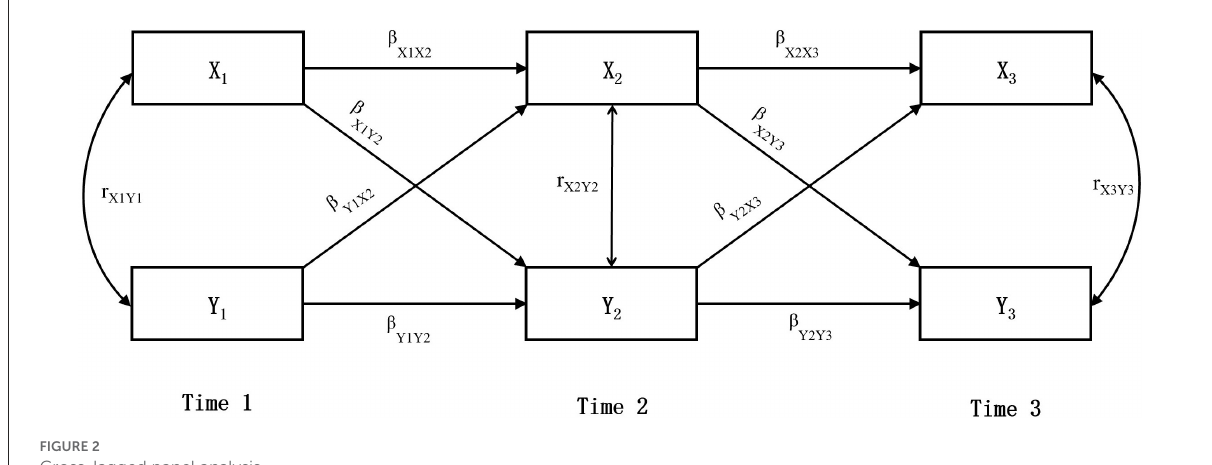
FIGURE2 Cross-lagged panel analysis.